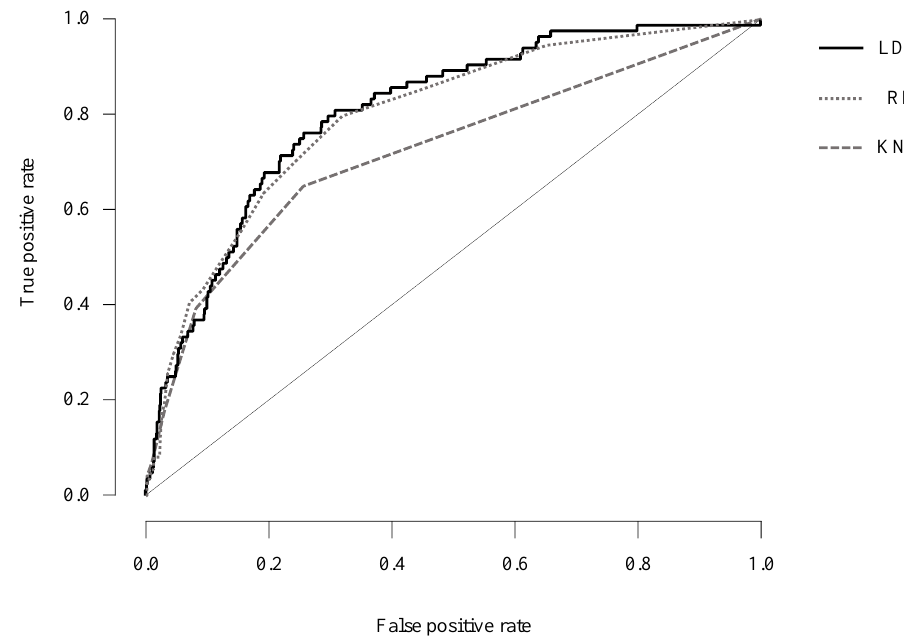
Figure 1. ROC curve plots for each machine learning methods; LDA: linear discriminant analysis; RF: random forest classification; KNN: K-nearest neighbors classification.